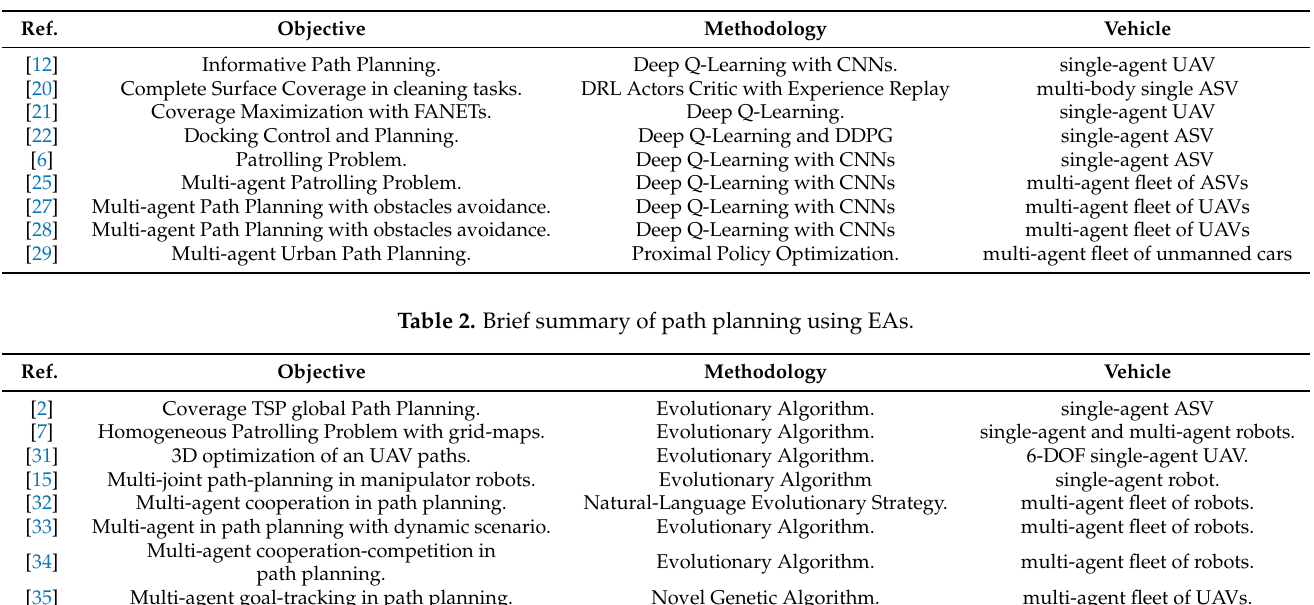
Table 1. Brief summary of path planning using DRL.